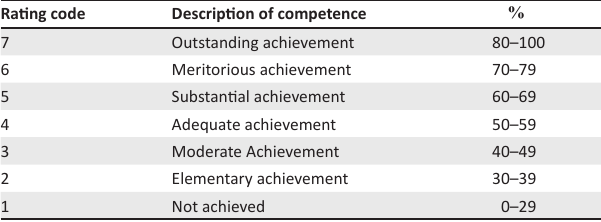
TABLE 1: Grading scales for Annual National